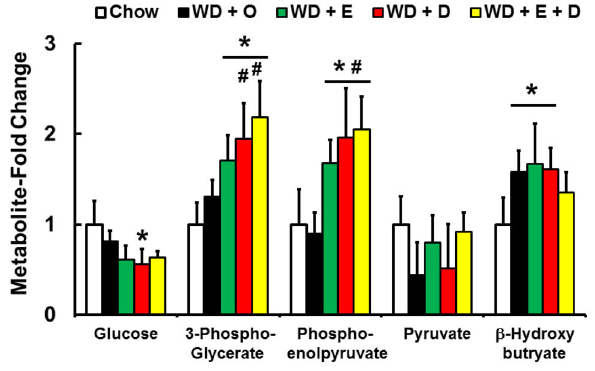
Figure 19. Diet effects on hepatic abundance of glycolytic metabolites that can be converted to methylglyoxal and S- lactoyl-glutathione. Hepatic metabolites were quantified by the metabolomic analysis (Methods) and represented as Metabolite-Fold Change, relative to chow-fed mice; mean ± SD, n=8/group; *, P ≤ 0.05 versus chow; #, P ≤ 0.05 versus WD + O. doi: